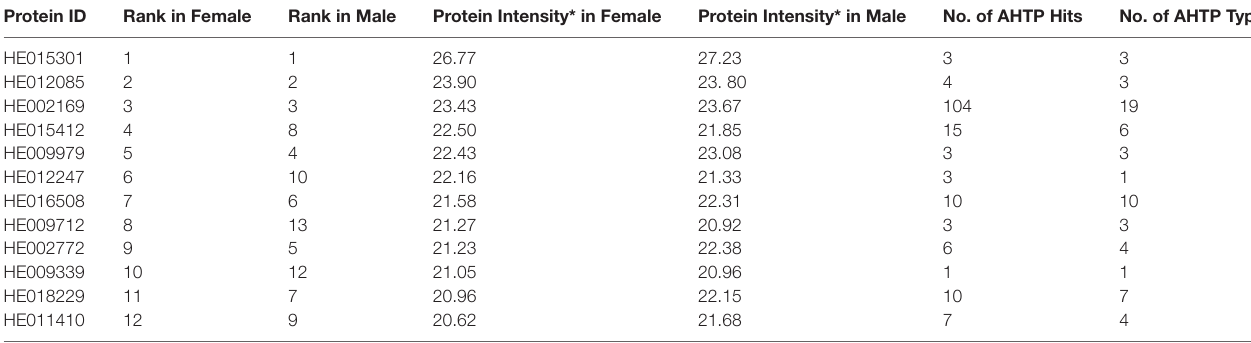
TABLE 2 | AHTP-derived proteins with the highest protein